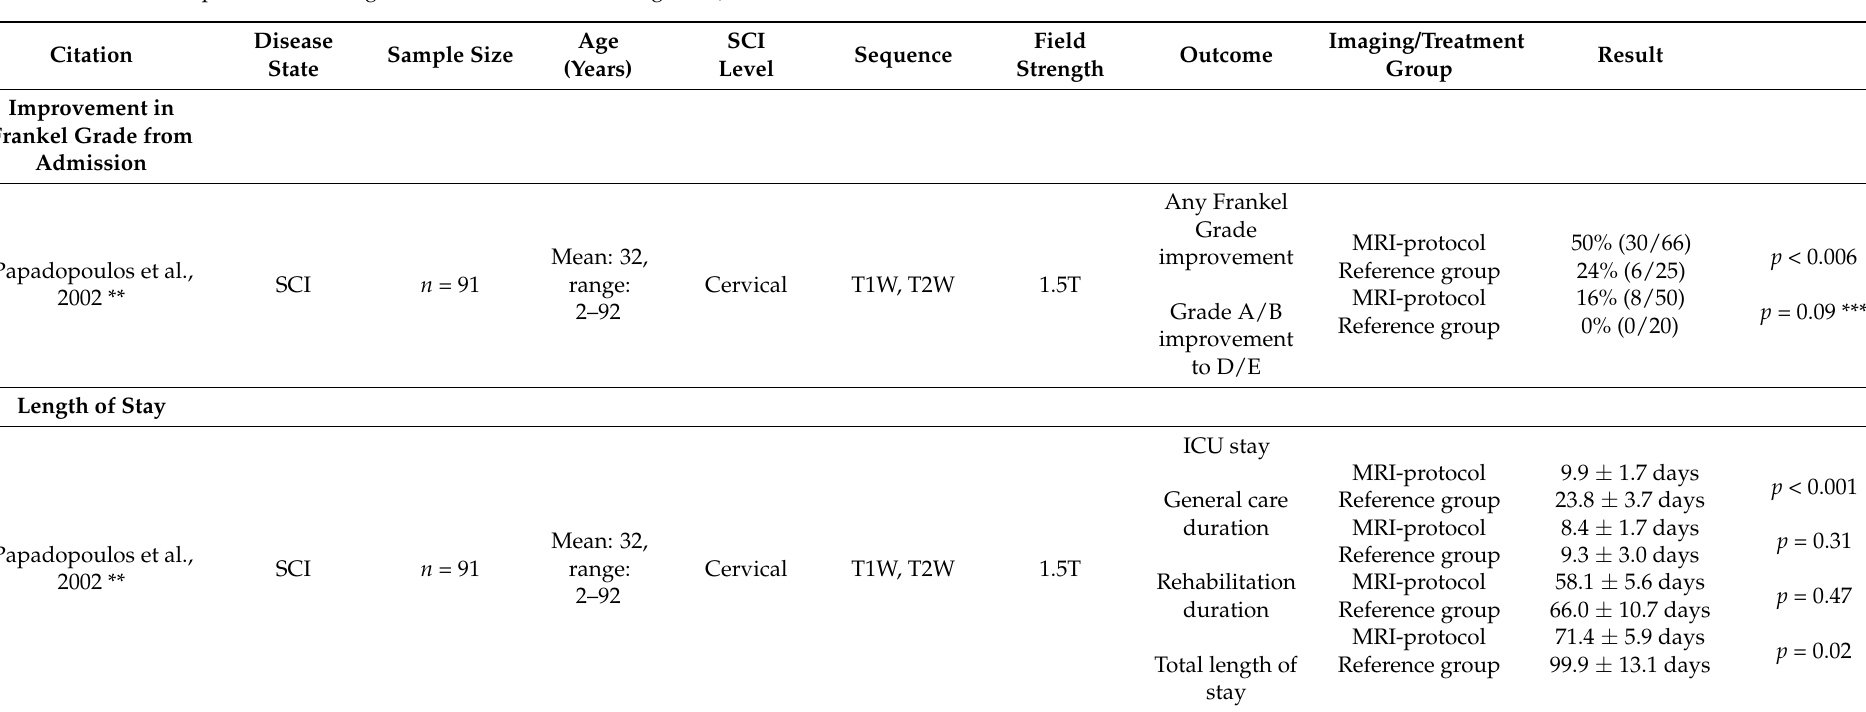
Table 8. Key Question 6: How does obtaining an MRI (compared with not obtaining MRI) affect neurological, functional, and health-related quality of life outcomes? (Differences in outcome between patients receiving MRI and those not receiving